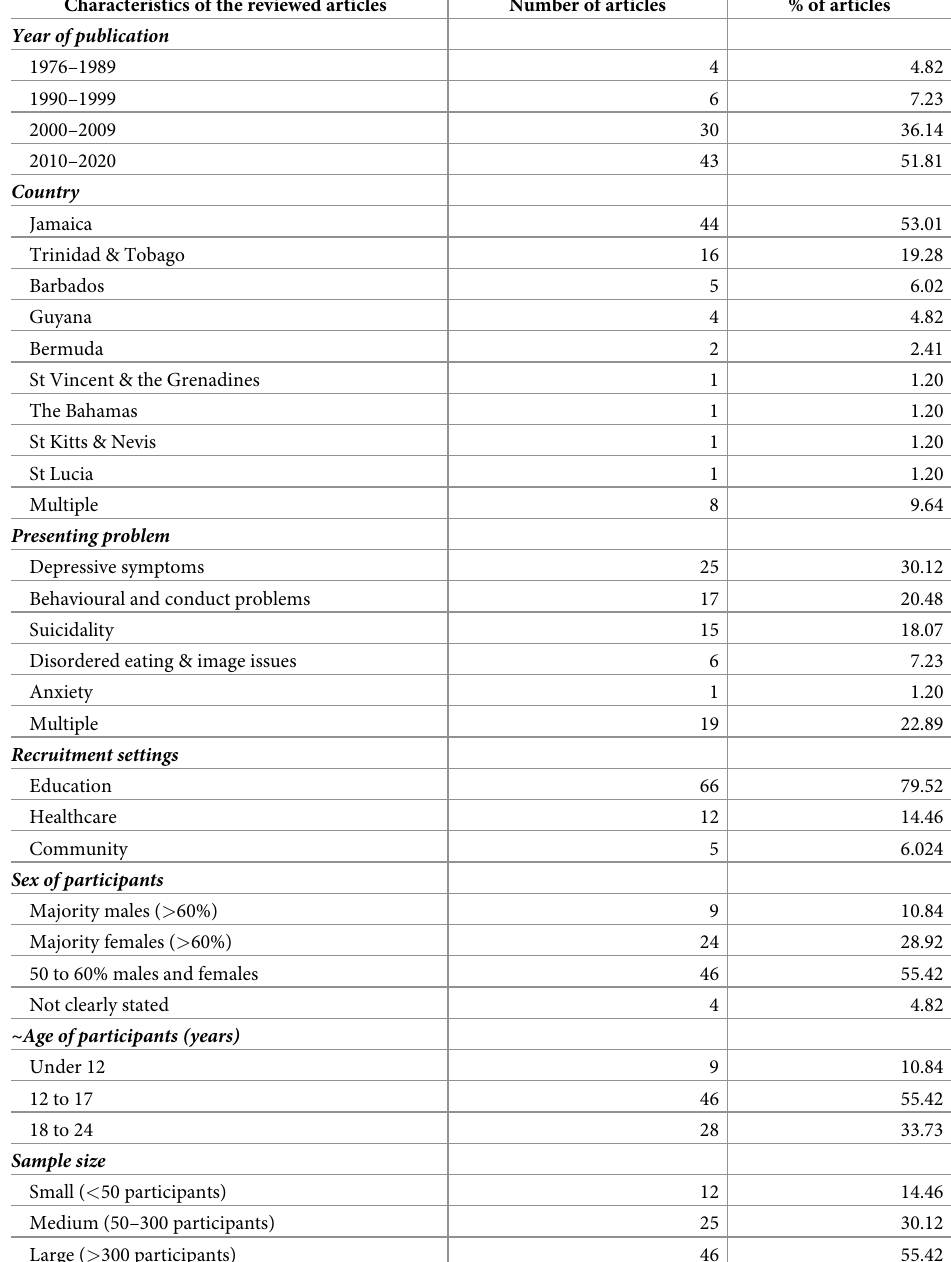
Table 1. Overview of the reviewed